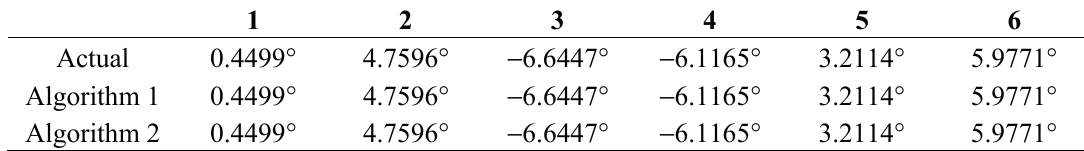
Table 10. Alignment results of the six simulations (pitch).